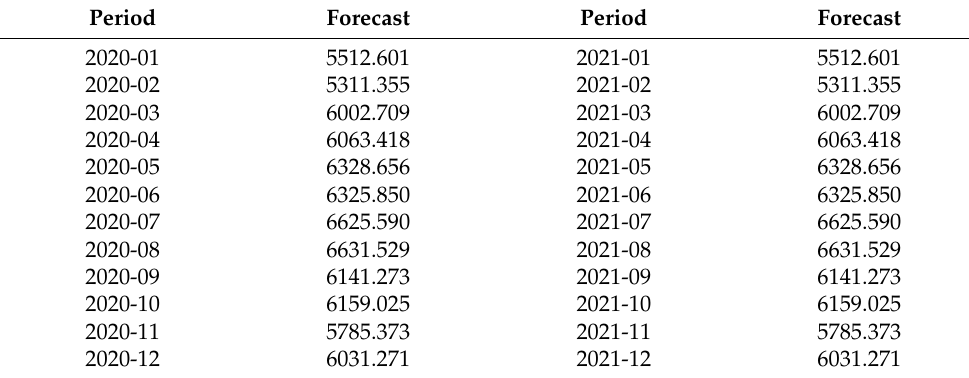
Table 6. Forecast errors. Source: own elaboration.